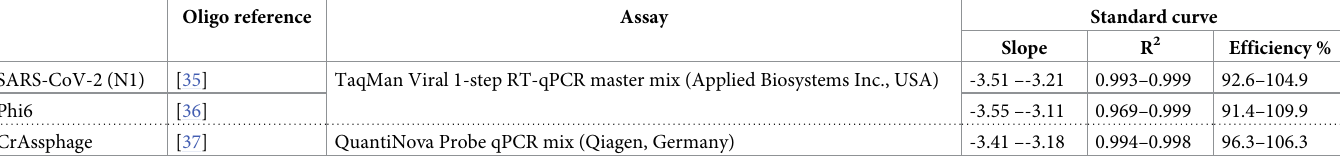
Table 3. RT-qPCR and qPCR assay details and performance for the viral targets. Oligo reference